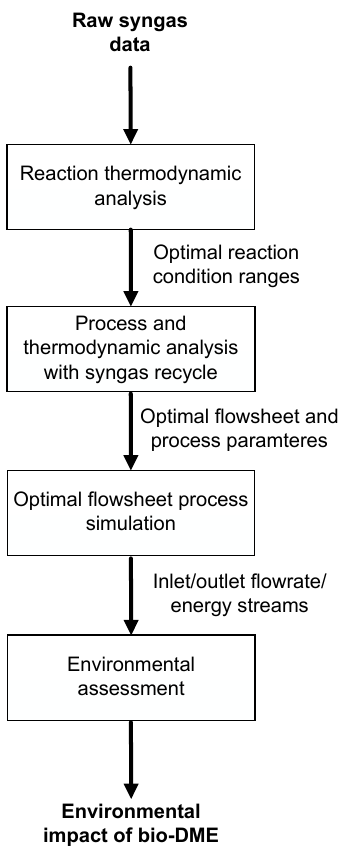
Figure 1. Procedure scheme to obtain the optimal bio-DME environmental assessment.